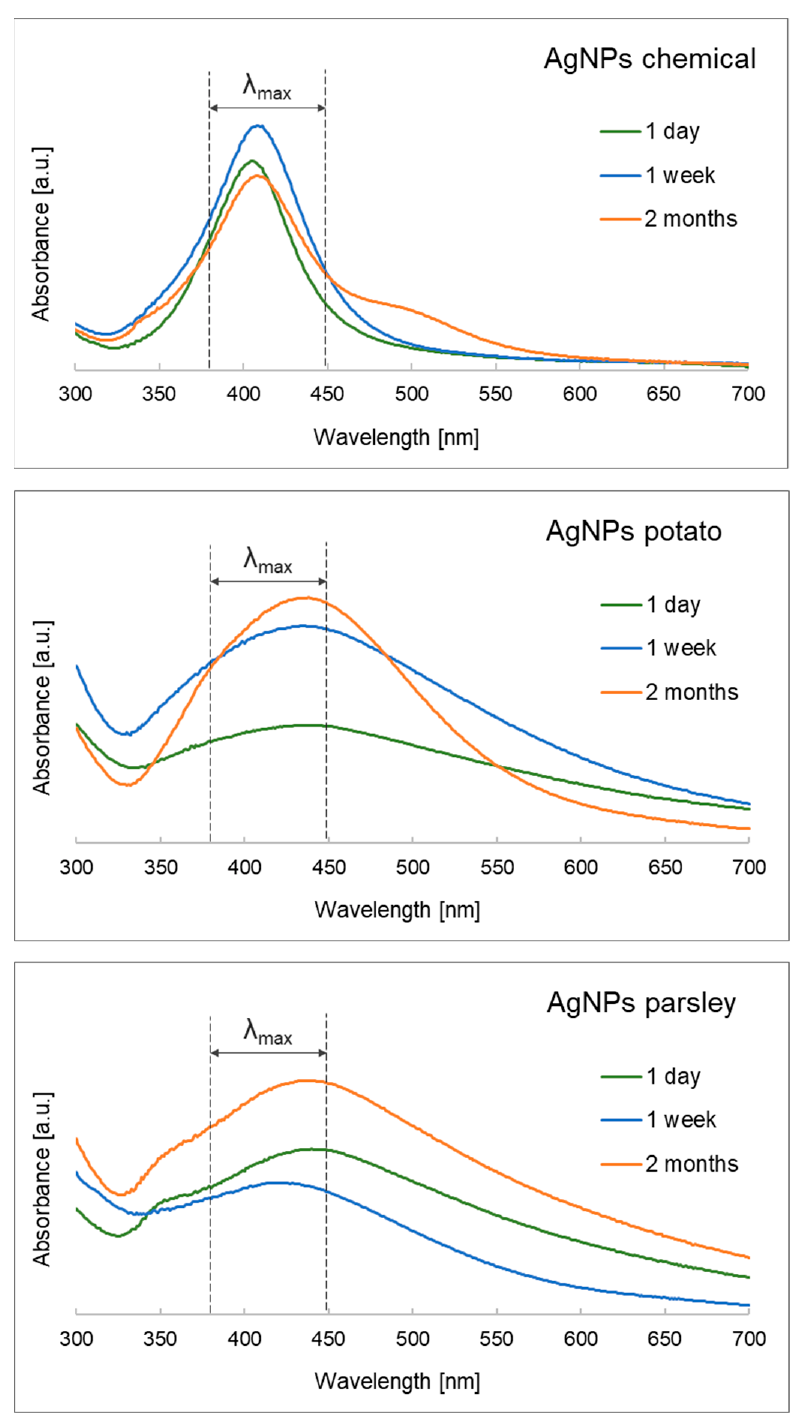
Figure 1. The UV-Vis spectra of silver nanoparticle suspensions depending on time and preparation method.